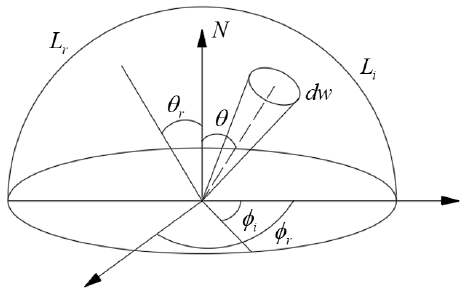
Figure 4. Geometric diagram of bidirectional scattering distribution function.